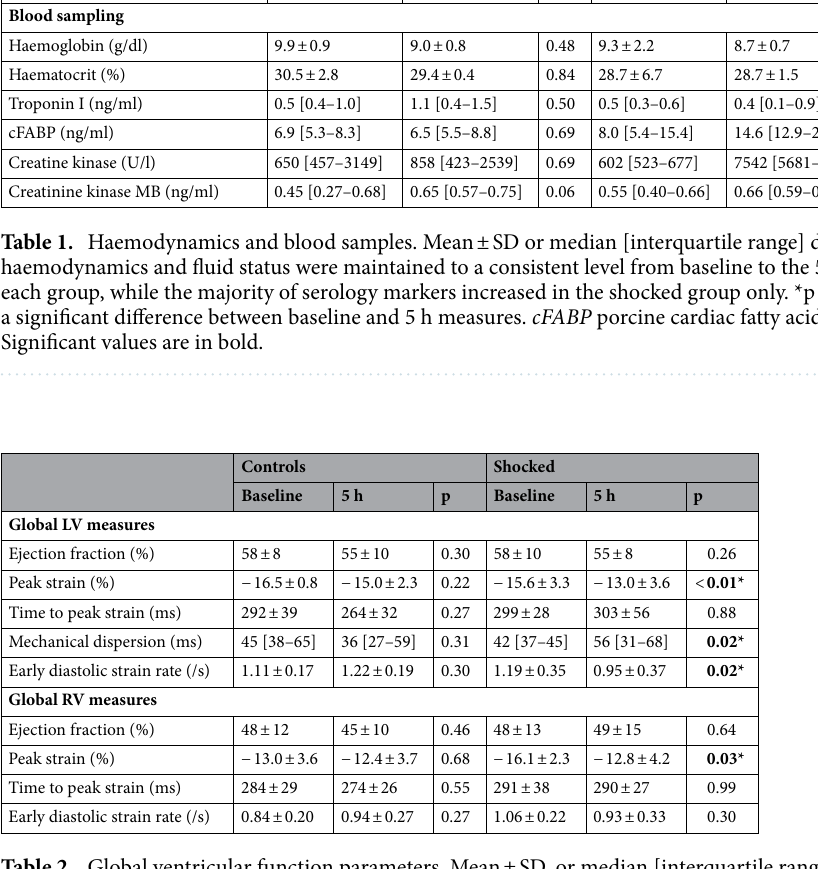
Table 2. Global ventricular function parameters. Mean ± SD, or median [interquartile range] are shown for global measures at baseline and the 5 h time point. *p < 0.05 represents a significant difference between baseline and 5 h measures. Significant values are in